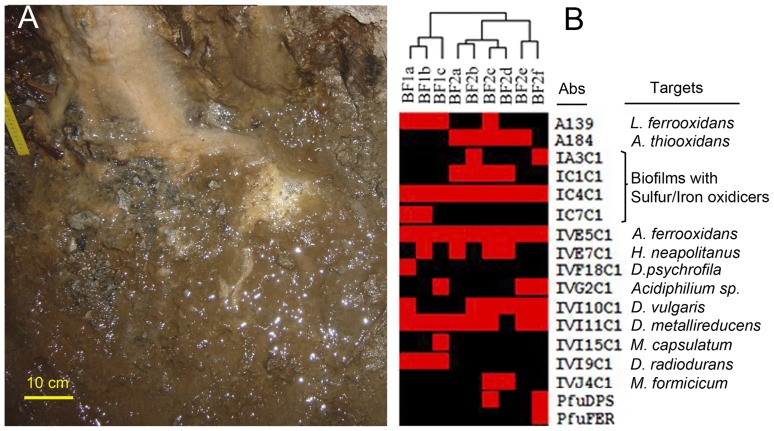
Studying deep South African mine biofilms by antibody microarrays.(A) a photograph of the biofilms on the corridor walls. Different colors might indicate different microbial communities and metabolisms. (B) Heat map representation of the immunoassay results from the longitudinal transects of BF1 and BF2 biofilms (BF1a, BF1b and BF1c, and BF2a, BF2b, BF2c, BF2d, BF2e and BF2f, respectively). The experimental filtered fluorescence intensity data are plotted in red for positive immunodetection and black for negative. The two major clusters of samples obtained by unsupervised hierarchically clustering grouped within the biofilm from which they were sampled.